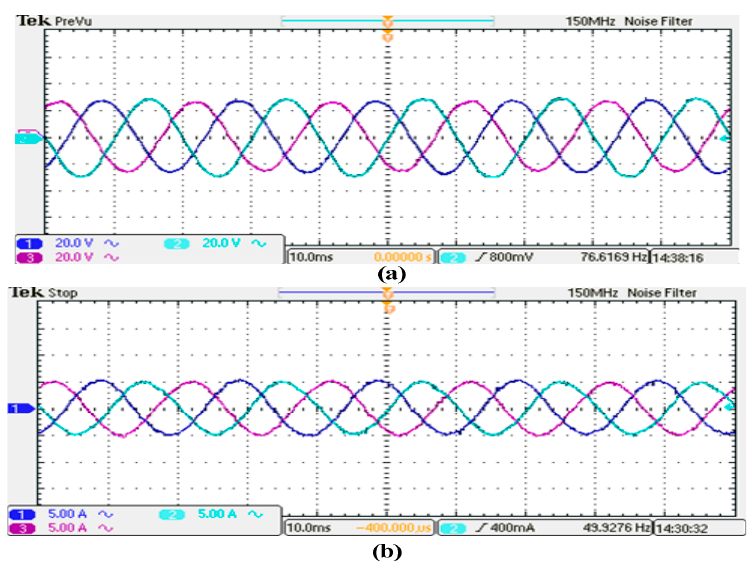
Figure 27. DFIG system in weak grid with low bandwidth Lead/Lag PLL (a) Stator voltage, and (b) Stator current.